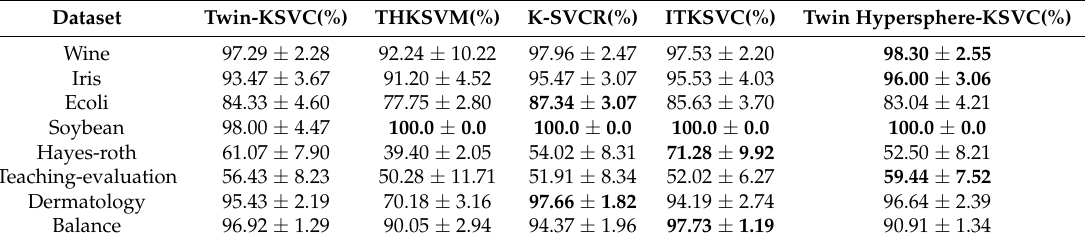
Table 3. Classification accuracy of THKSVM, ITKSVC, Twin-KSVC, K-SVCR and Twin Hypersphere-KSVC on UCI benchmark datasets.